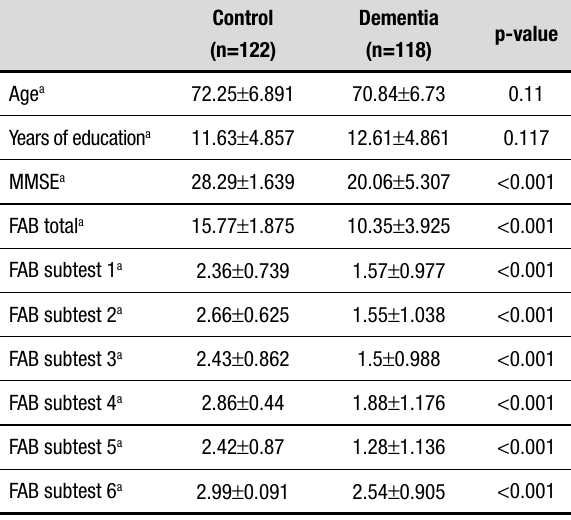
Table 2. Demographic and neuropsychological characteristics of healthy controls and patients matched by age and education